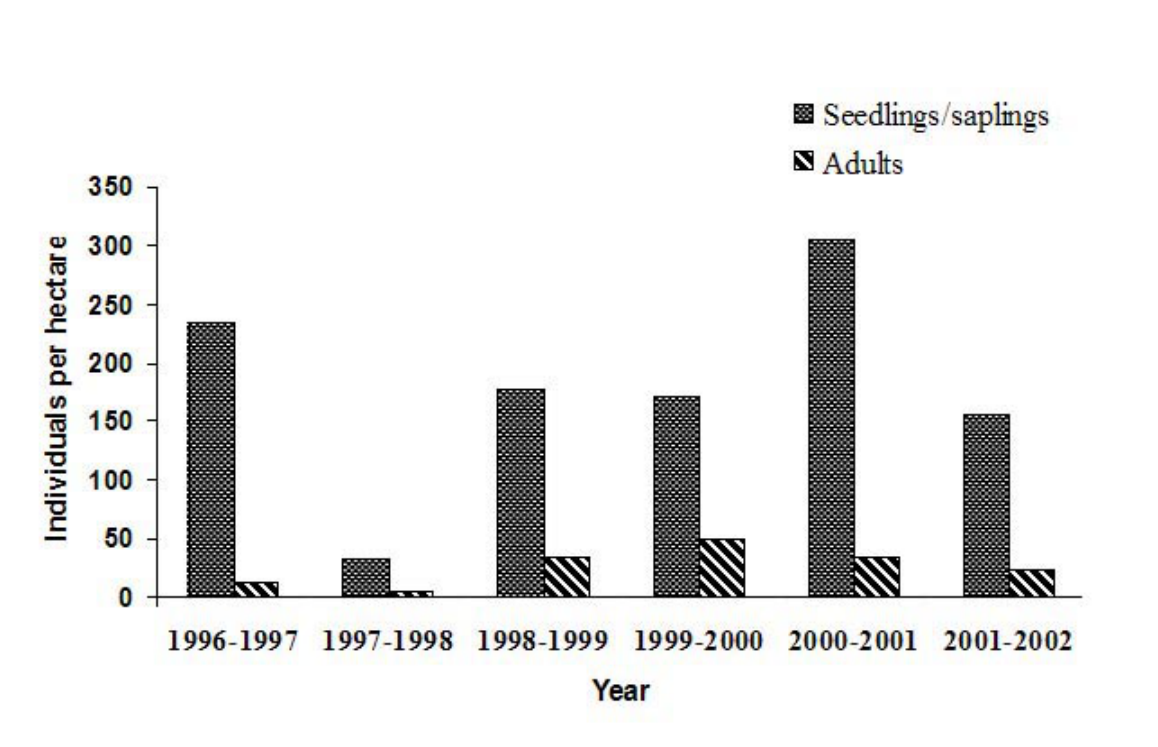
Fig. 3 . Population structure of amla ( Phyllanthus emblica and P. indofishceri ) estimated using participatory resource management